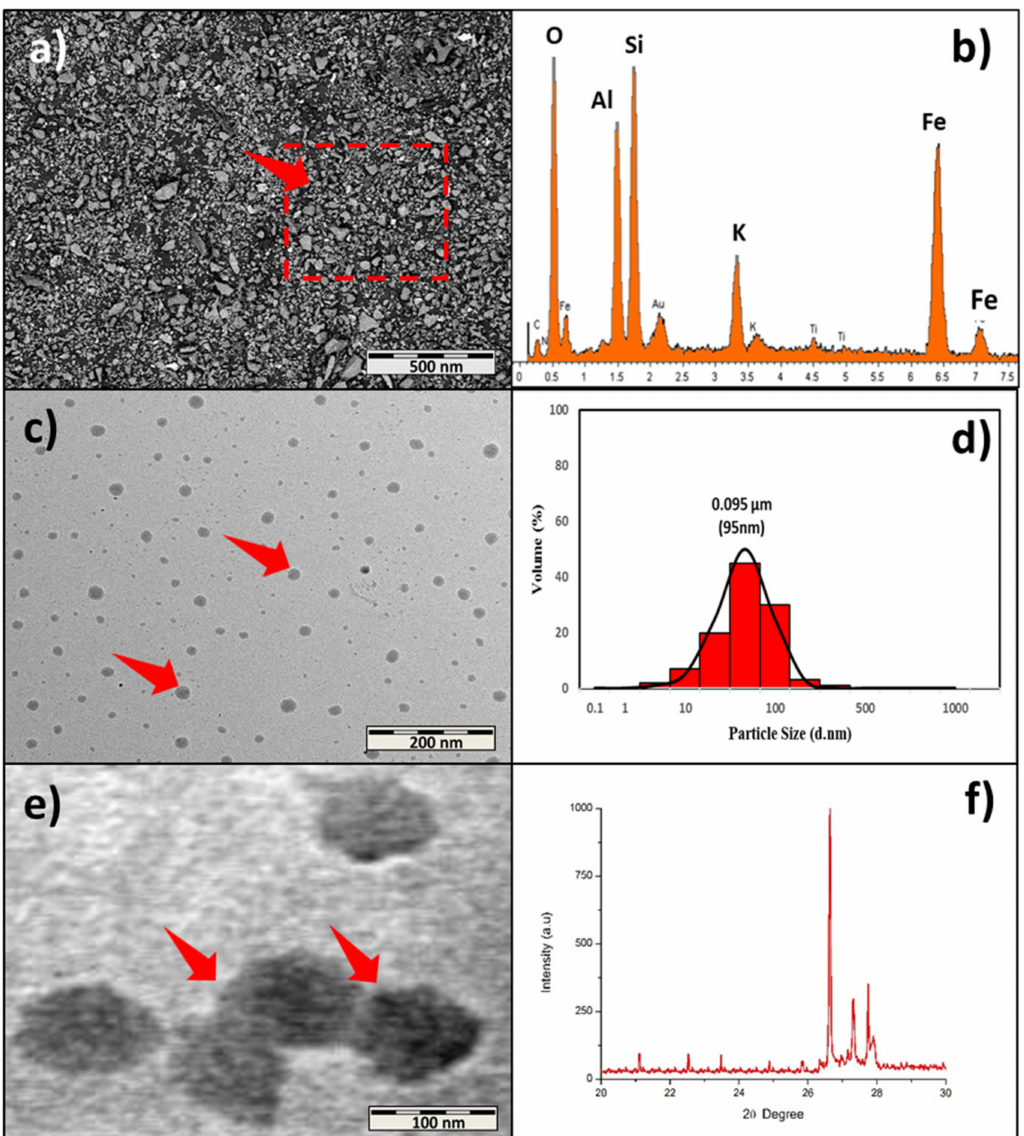
Figure 2. Properties of oil palm bio-ash nanoparticles. ( a ) FESEM morphology, ( b ) EDX element composition, ( c ) TEM micrograph of OPB distribution, ( d ) OPB nanoparticle distribution, ( e ) TEM micrograph of OPB, and ( f ) OPB XRD